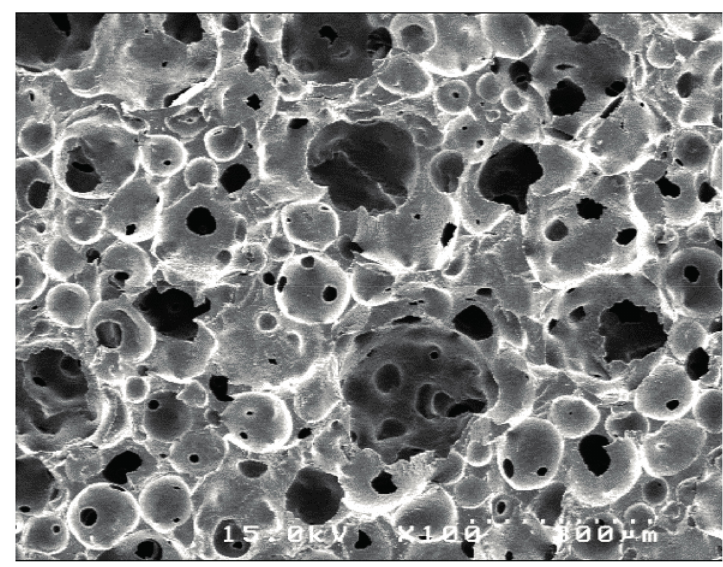
Figure 3. SEM image of the interconnected porous hydroxyapatite (IP-CHA) scaffold. Almost all pores are